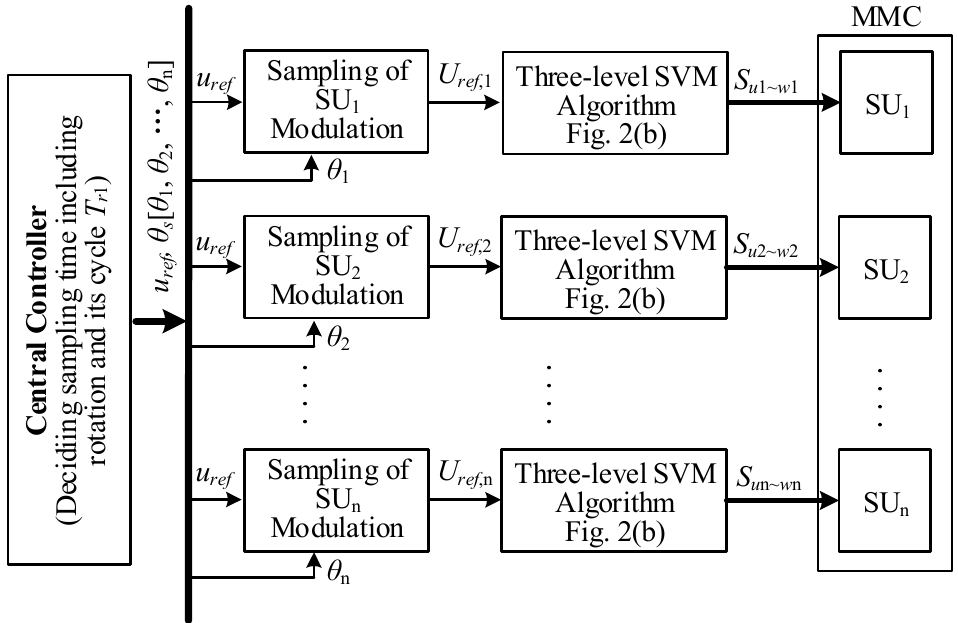
Figure 3. Schematic diagram of the presented SVM for MMC.